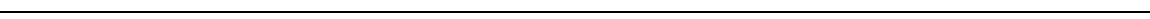
Fig. 3 Dsg1 – Tctex-1 interactions promote perijunctional actin polymerization. Quanti fi cation of the cell area of differentiated NHEKs treated with control (siNeg) or Tctex-1 siRNA ( a ) or undifferentiated NHEKs infected with GFP, Dsg1-FL-Flag, or Dsg1-909-Flag ( b ) shown in Whisker plots. Box boundaries indicate the range of cell areas measured, middle bars depict the mean of compiled data sets, whiskers represent the maximum and the minimum of the measured areas (collected from three independent experiments and areas of at least 125 cells were measured per condition, *** p < 0.001, unpaired two- tailed t test in a and one-way Anova with Tukey test in b , F = 68.519). c Z-volume reconstructions of the cell – cell borders of undifferentiated NHEKs retrovirally transduced with Dsg1-FL-Flag or Dsg1-909-Flag. NHEKs were stained for Flag (green) and E-cadherin (red) and imaged using structured illumination microscopy (SIM). Rectangles mark zoomed in areas. The lateral distance between E-cadherin and Dsg1 at cell contacts of NHEKs is quanti fi ed to the right (three independent experiments; *** p < 0.001, unpaired two-tailed t test). d GFP, Dsg1-FL-Flag, or Dsg1-909-Flag-infected NHEKs were stained for F-actin and Flag (green). e Line scan analyses of cortical F-actin intensities at the cell – cell interface in undifferentiated NHEKs expressing GFP or ectopic Dsg1-Flag constructs (three independent experiments, at least 50 borders were analyzed per condition in each experiment ( F = 46.432, ** p < 0.01, one- way Anova with Tukey test). f Representative SIM images of F-actin (gray/red) and Flag (green) at the cell – cell interface of undifferentiated NHEKs expressing GFP, Dsg1-FL-Flag, or Dsg1-909-Flag. g Barbed-end labeling (G-actin incorporation) at cell junctions in undifferentiated NHEKs expressing GFP, barbed ends (red) and Flag (green). h Quanti fi cation of barbed-end labeling in undifferentiated NHEKs expressing GFP or ectopic Dsg1 constructs (at least 10 μ m. Error bars represent